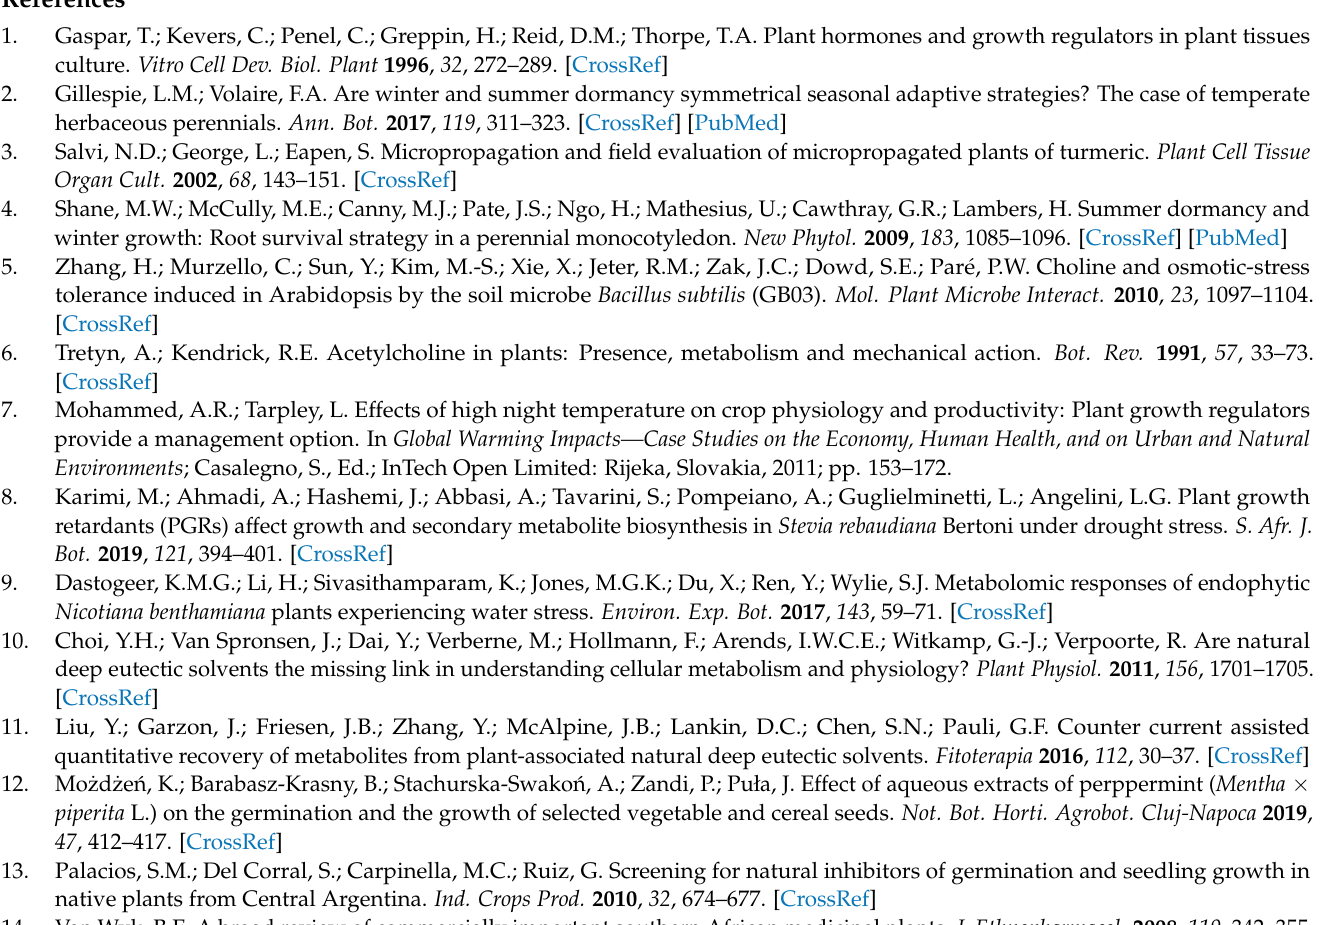
2.43 ppm; Figure S6: Spiking of the leachate sample with choline; Figure S7: Spiking of the leachate sample (red) with lactose; Figure S8: Anomeric proton peak of lactose at 5.17 ppm; Figure S9: The leachate extract (red) spiked with gallic